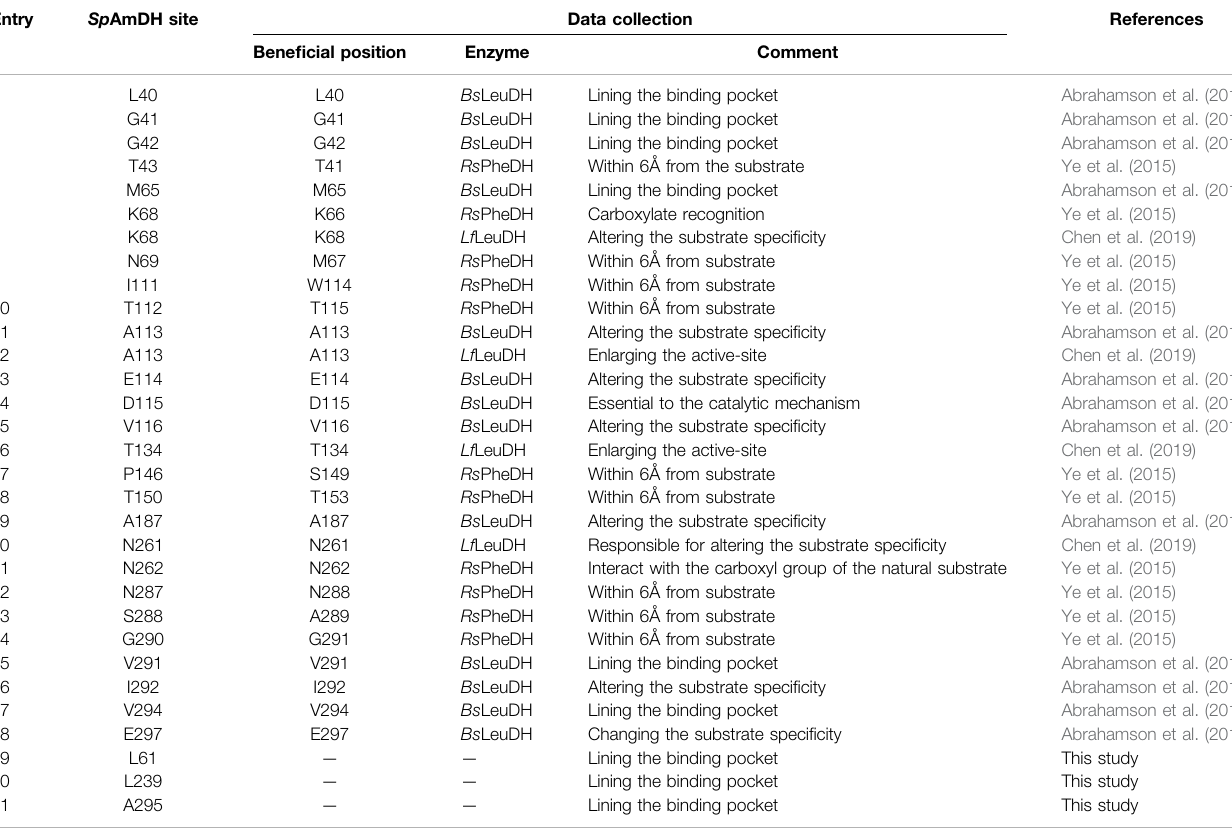
TABLE 1 | Key residues selected for engineering Sp AmDH based on published